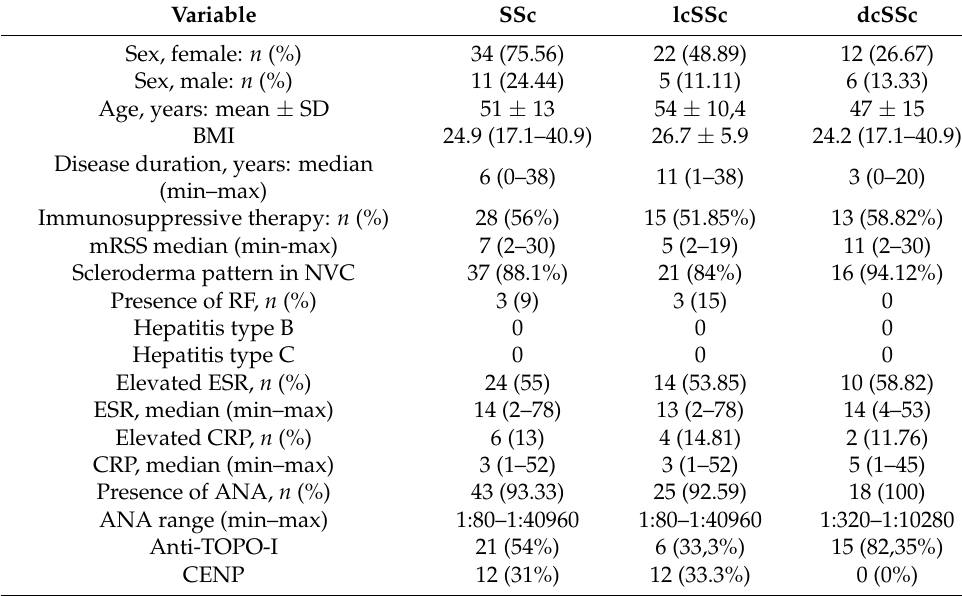
Table 1. Demographic data and SSc patients’